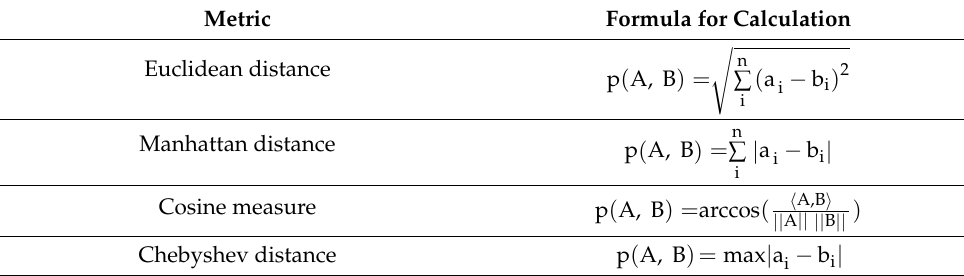
Table 1. Metrics used to determine the distance between time series A and